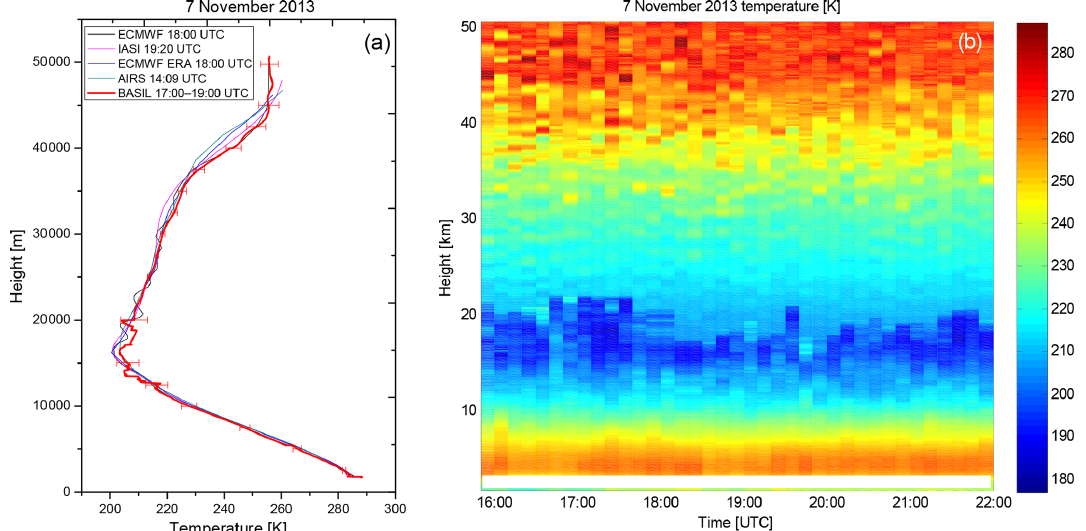
Figure 4. Vertical profile of atmospheric temperature as measured by BASIL over the time period from 17:00 to 19:00UTC on 7 November 2013 as well as the closest profiles (in time) from IASI (at 19:20UTC), AIRS (at 14:09UTC) and the ECMWF (ERA-15 and ERA-40, at 18:00UTC) model reanalysis (a) . Time evolution of the atmospheric temperature profile as measured by BASIL over the interval from 18:00 to 22:00UTC on 7 November 2013 (b)